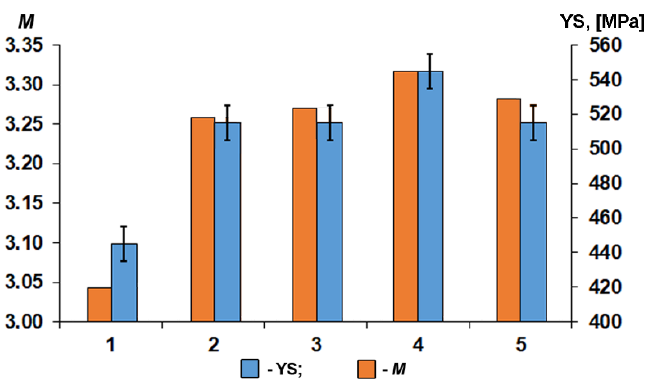
Figure 9. Comparison of yield stress with the averaged Taylor factors for pipeline steel specimens in TD.